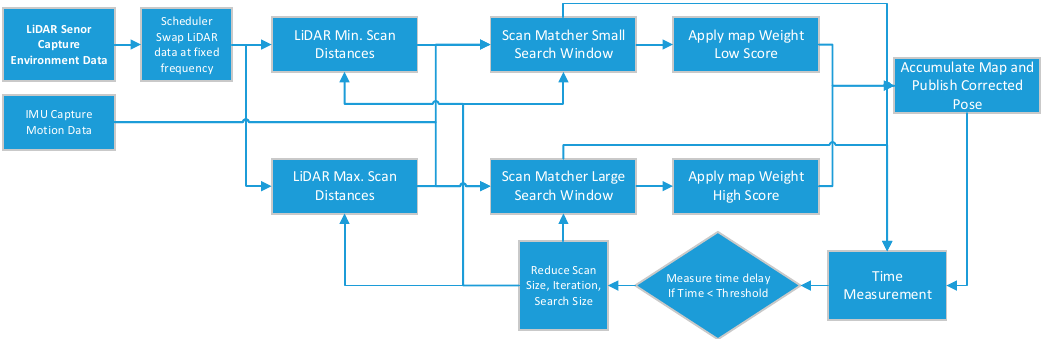
Figure 4. Adaptive multi-distance control applied on local SLAM.